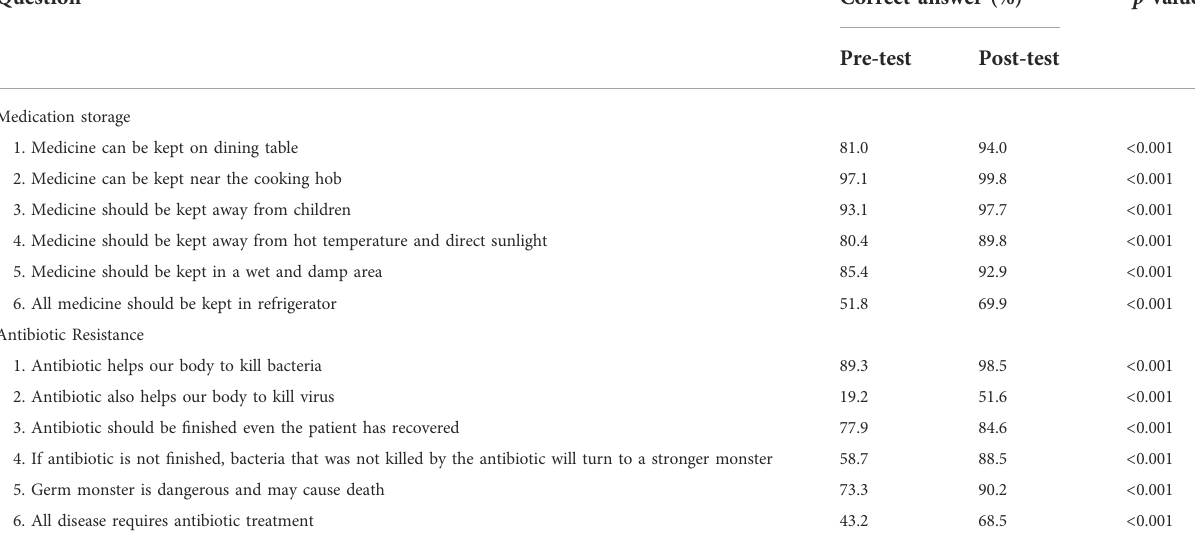
TABLE 6 Children knowledge changes based on